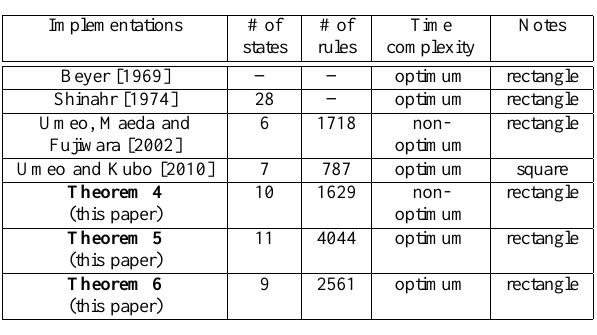
A LIST OF IMPLEMENTATIONS FOR 2D RECTANGLE FSSP ALGORITHMS